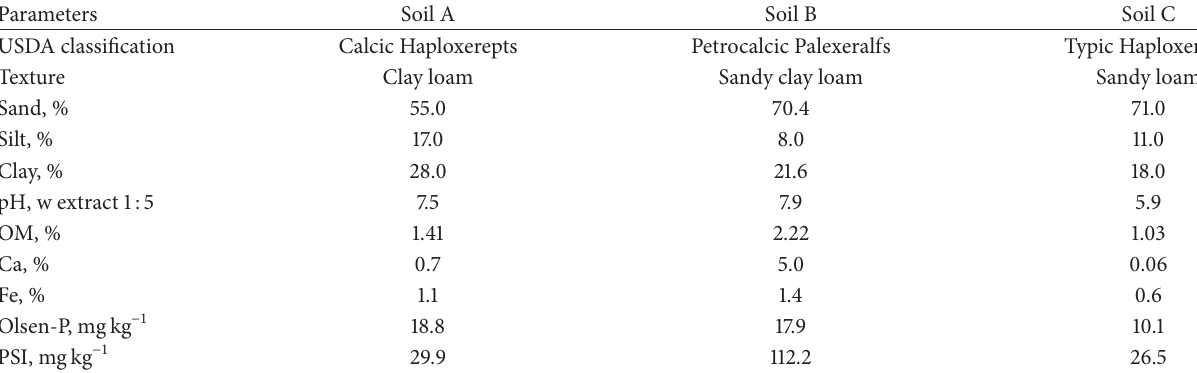
Table2:Biowastechemicalcharacterization:compostanddigestate.